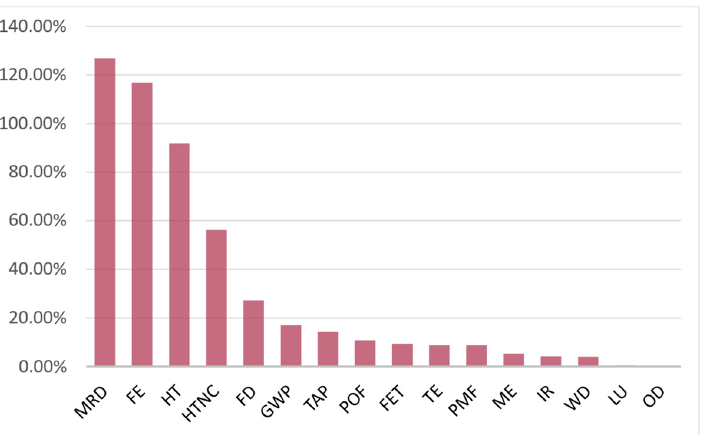
Figure 4. Hierarchy of environmental impacts, with the use of planetary limits as normalization. Environmental impacts calculated for an inverter operating point with a 150 kW load from a DC power source of 450 V, based on 15 years encompassing 10,000 operating hours. This depiction represents the standardized environmental impacts, according to the European Commission [27]. Relevant abbreviations are presented in Table 1.